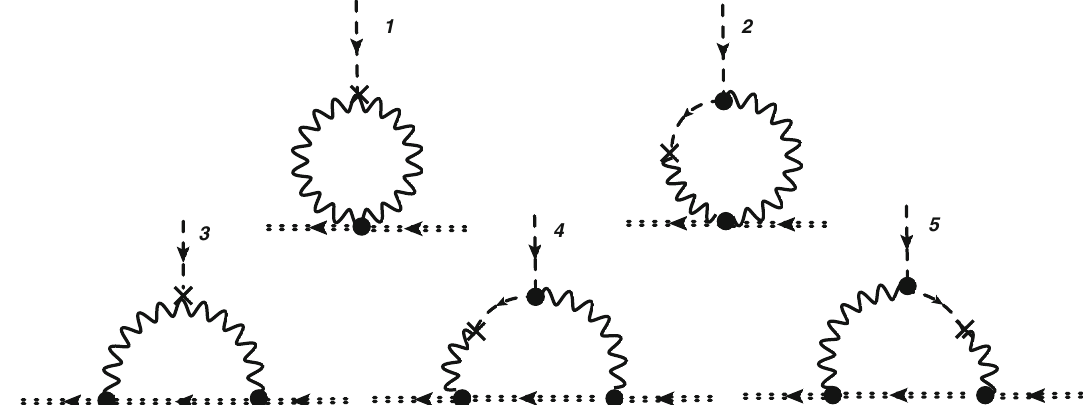
Fig. 3 One-loop Feynman diagrams contributing to the three point Green’s function of the Gluino-Glue operator, (cid:7) c O Gg ¯ c ¯ λ (cid:5) . A wavy (dashed) line represents gluons (gluinos). A cross denotes the insertion